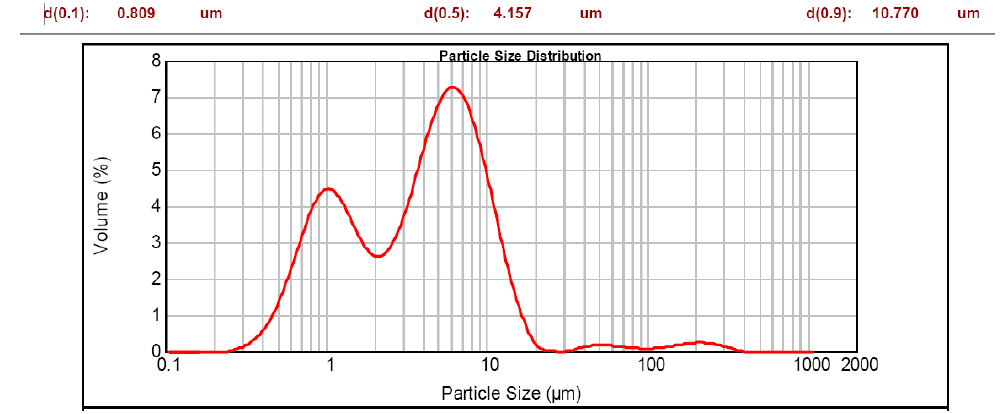
Figure 2. Representation of a bimodal bitumen emulsion particle size distribution.